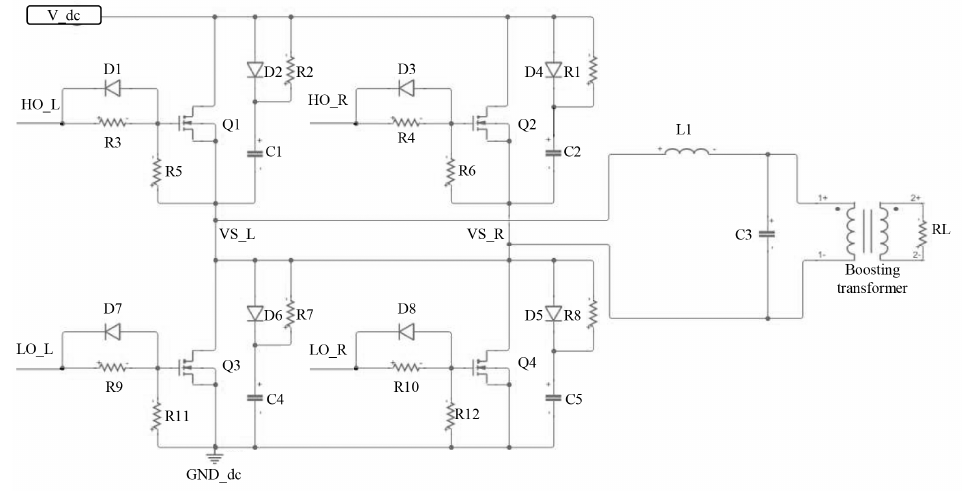
Figure 4. Schematic diagram of the single-phase full-bridge voltage type sinusoidal pulse width modulation (SPWM) inverter circuit.